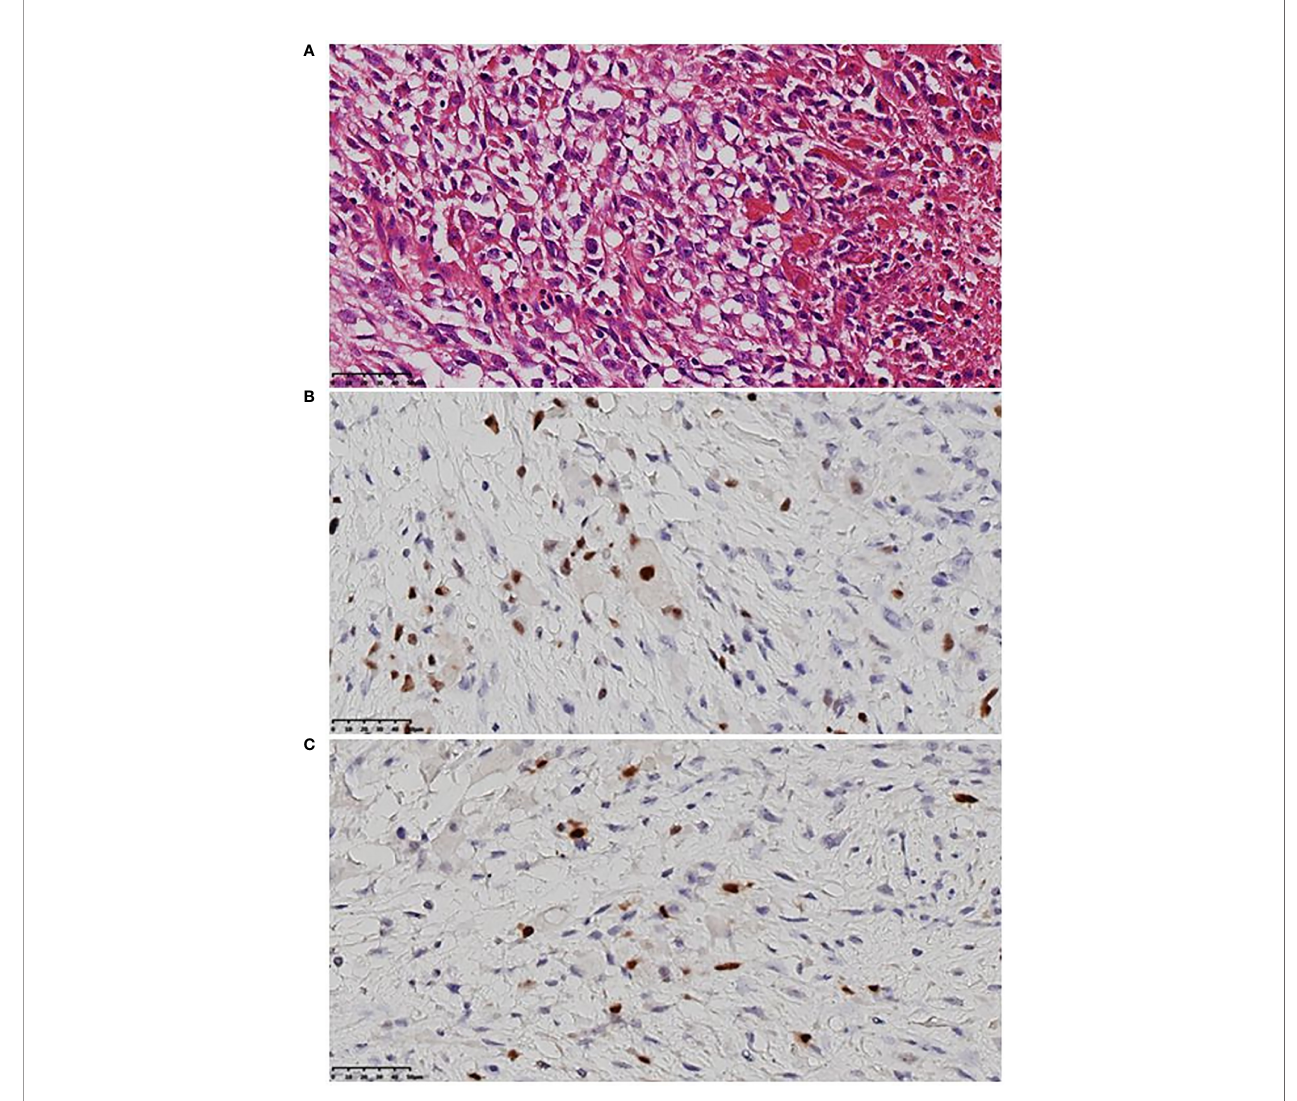
FIGURE 2 | Representative histologic images of rhabdomyosarcoma. (A) Malignant mesenchymal tumor, mainly spindle cells, clear cytoplasm or acidophilic tumor cells, severe atypia, large and hyperchromatic nuclei, irregular karyotype, and visible mitotic image. (B) MyoD1 (+) by immunohistochemistry. (C) Myogenin (focal +) by